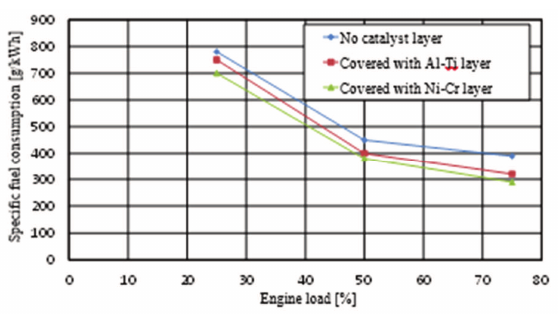
Fig. 5. Specific fuel consumption as a function of engine load